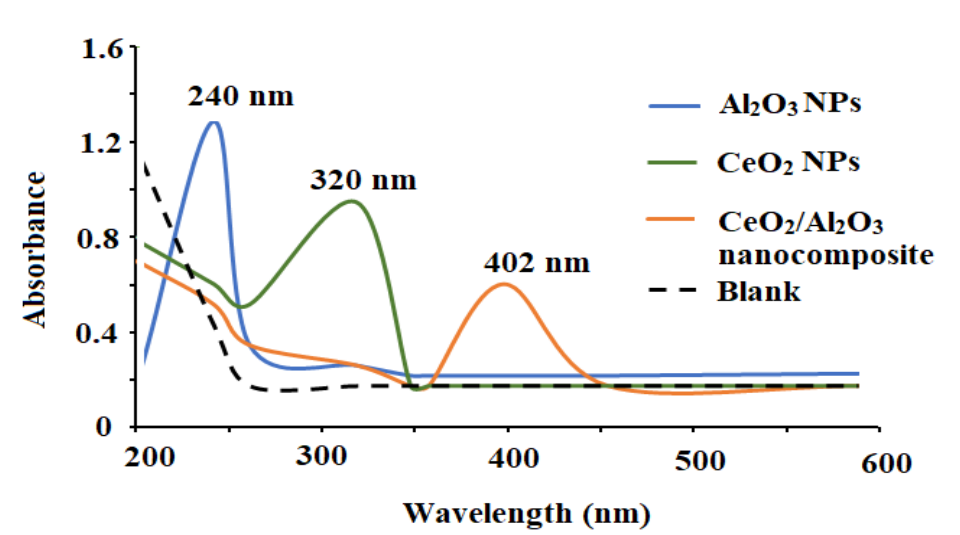
Figure 3. The optical spectra of the synthesized CeO 2 NPs, Al 2 O 3 NPs, and CeO 2 /Al 2 O 3 nanocomposite measured at wavelength 200–600 nm.